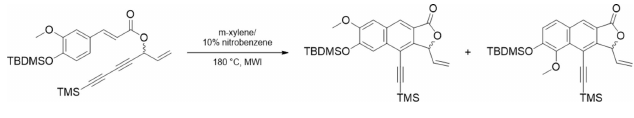
Figure 1 Reaction scheme to afford the title compound along with its regioisomer.